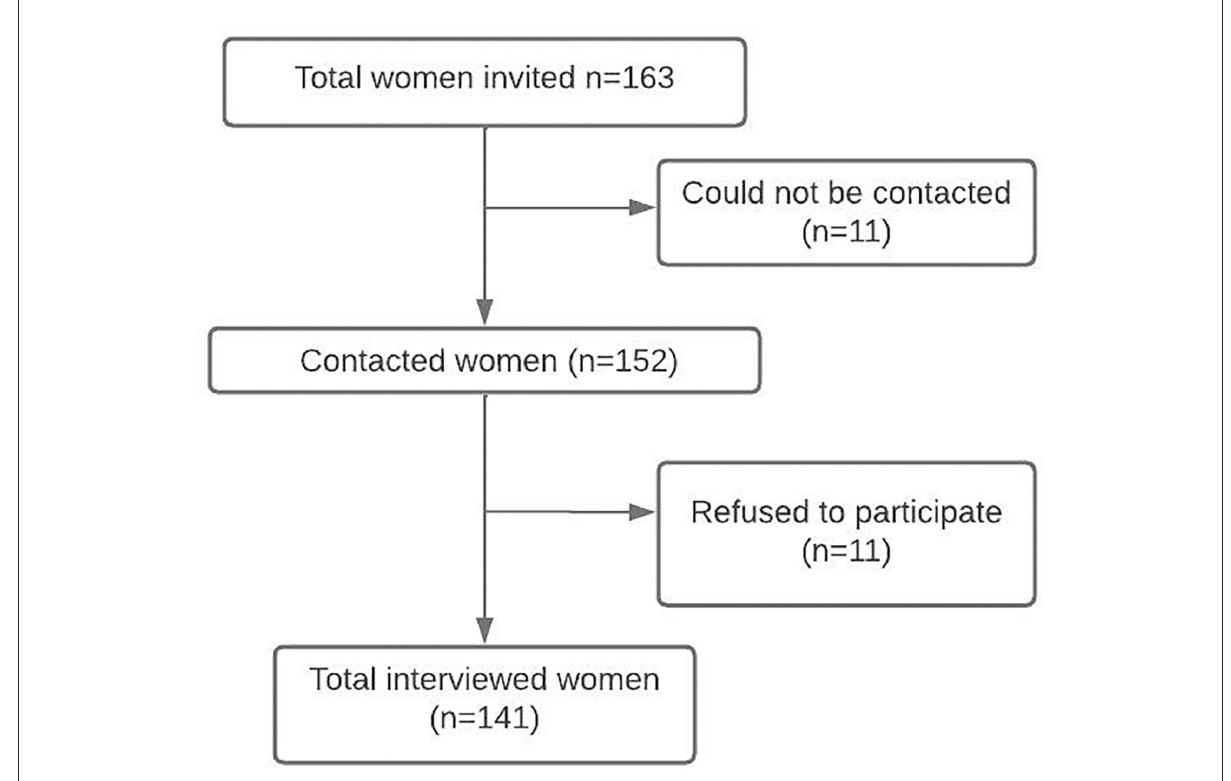
FIGURE1 Study sample flowchart of women with MS